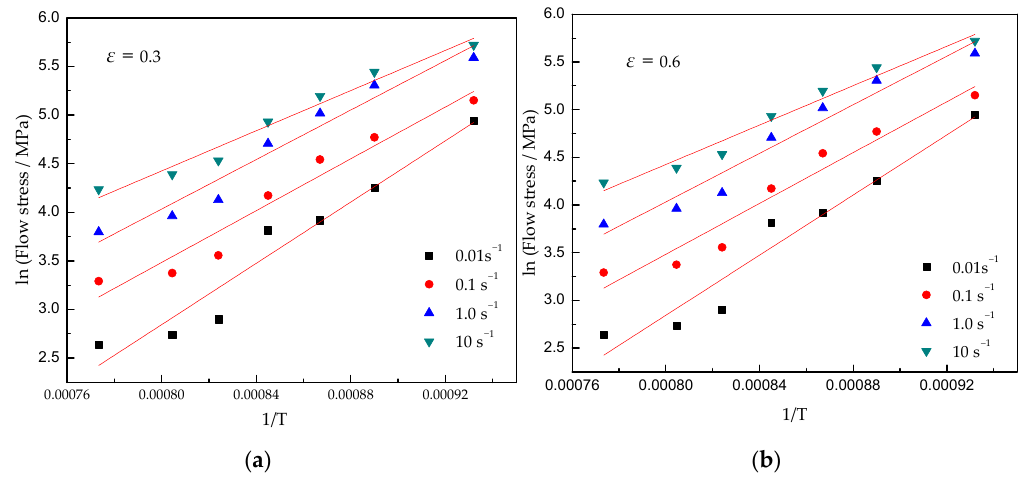
show a linear relationship according to Figure 8, the flow stress model of the Ti–3.3Al–1.5Zr–1.2Mo–0.6Ni titanium alloy can be expressed as follows: